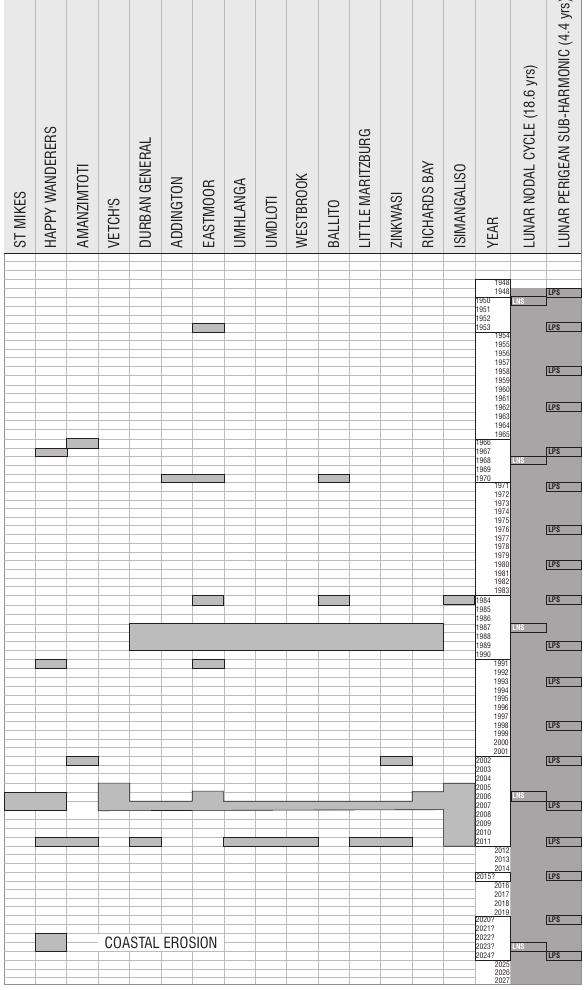
COASTAL EROSION